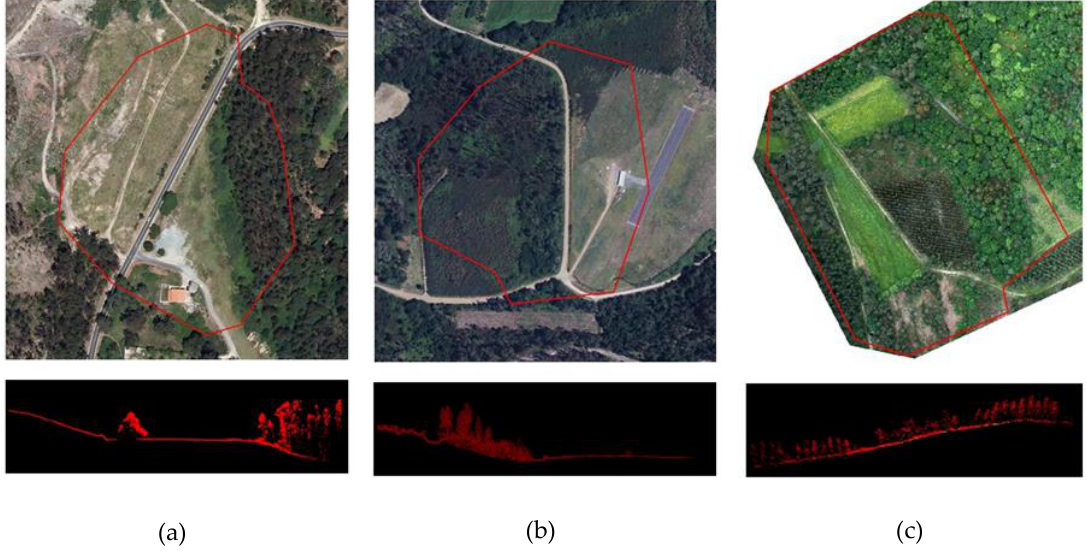
Figure 2. Aerial photography and LiDAR profile of Dataset 1 ( a ), Dataset 2 ( b ), and Dataset 3 ( c ). 121